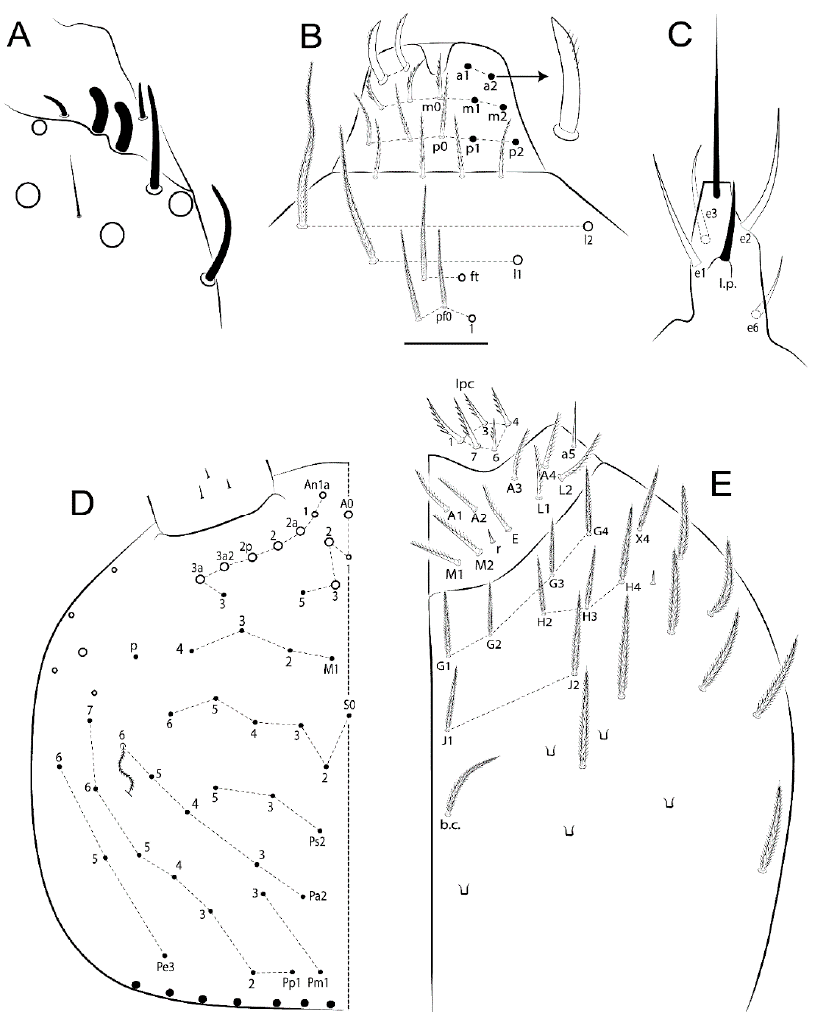
Figure 31. Pseudosinella taurina sp. nov.: head. ( A ) Ant III apical organ (lateral view); ( B ) chaetotaxy of clypeus, prelabrum, and labrum; ( C ) labial papilla E (right side); ( D ) head dorsal chaetotaxy (left side); ( E ) labial proximal chaetae, basomedian and basolateral labial fields, and complete postlabial chaetotaxy (right side).